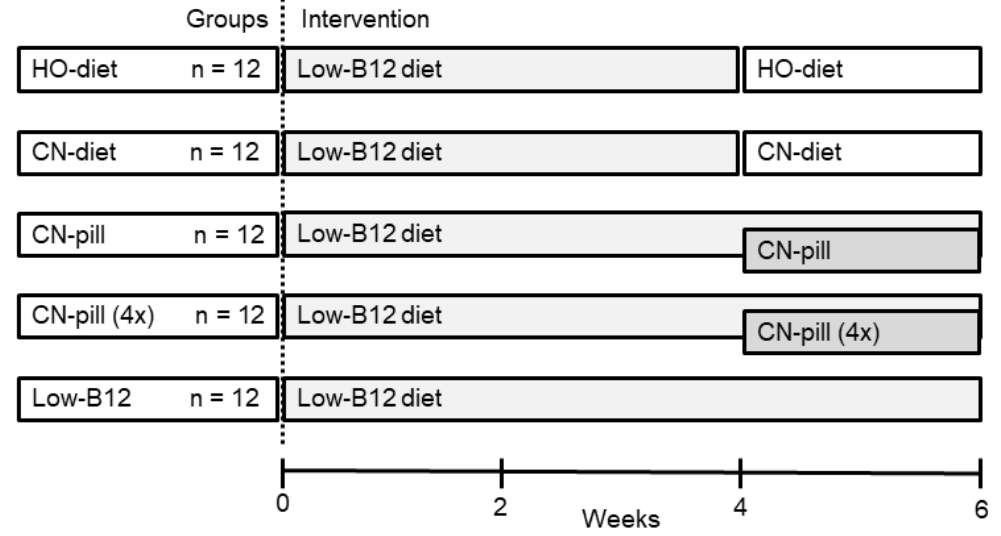
Figure 1. Study design. Male Wistar rats ( n = 60) received a low-B12 diet for four weeks, followed by two-weeks intervention with B12 in the form of custom-made diets with added B12 (hydroxo-diet (HO-diet), 0.72 µg B12/day; cyano-diet (CN-diet), 0.72 µg B12/day) or a single daily B12 dose embedded in a jelly bean (mimicking a daily vitamin pill) (CN-pill, 0.72 µg B12/day; and, CN-pill (4×), 2.88 µg B12/day). A control group (Low-B12) continued on the low-B12 diet for the six weeks duration of the